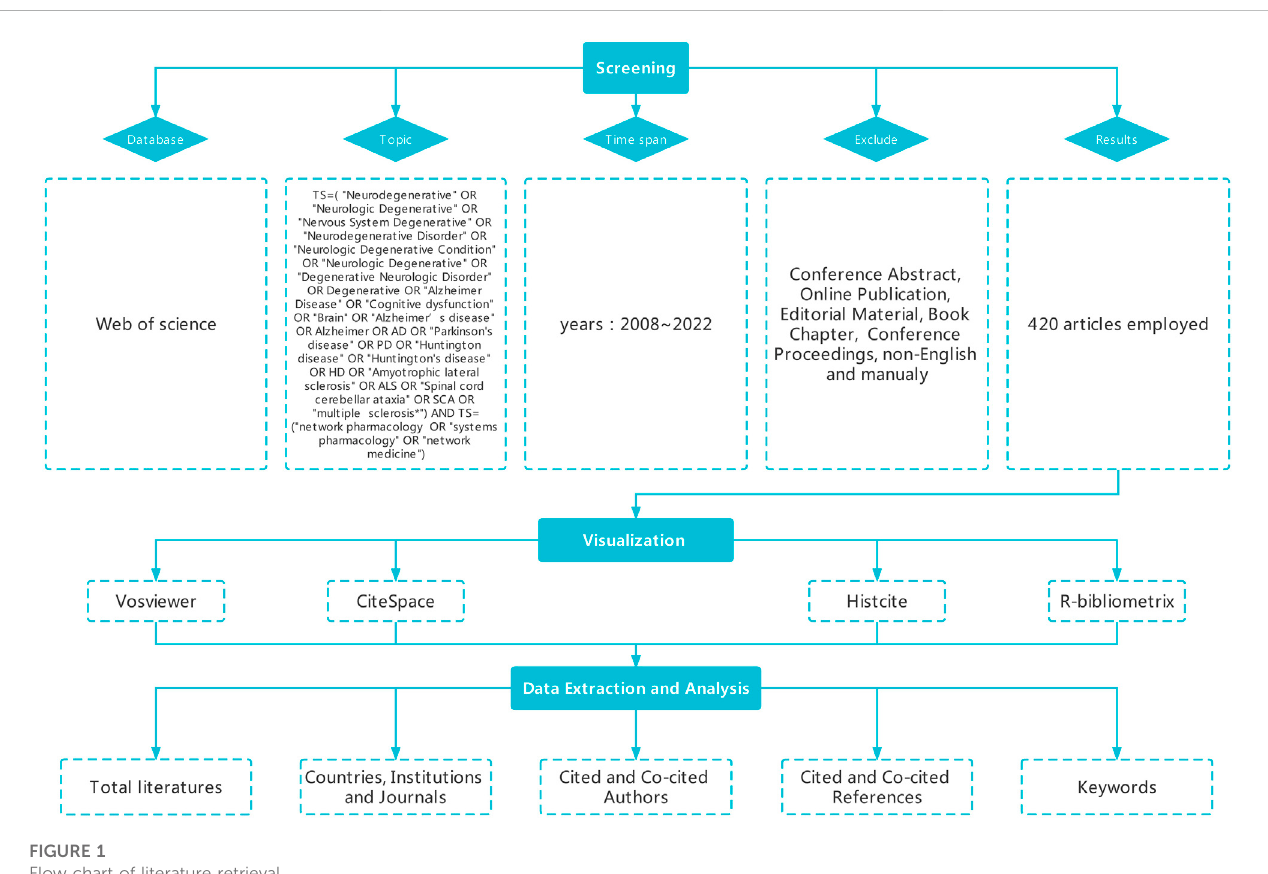
FIGURE 1 Flow chart of literature retrieval.